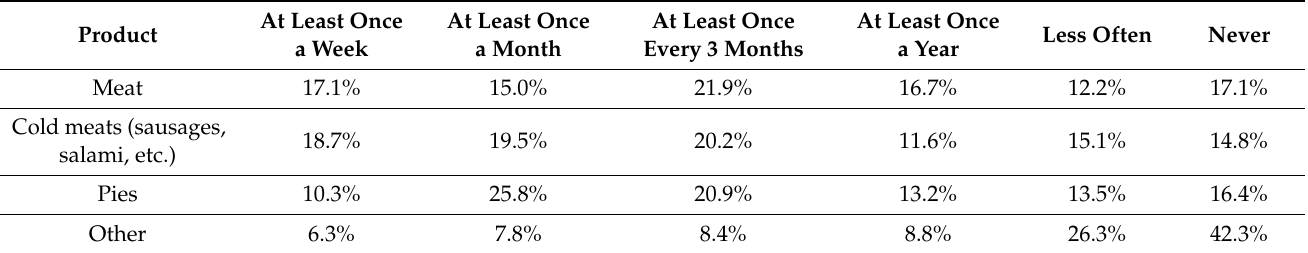
Table 6. What kind of game or game-based food do you buy (whether for yourself or members of your household) ( n =